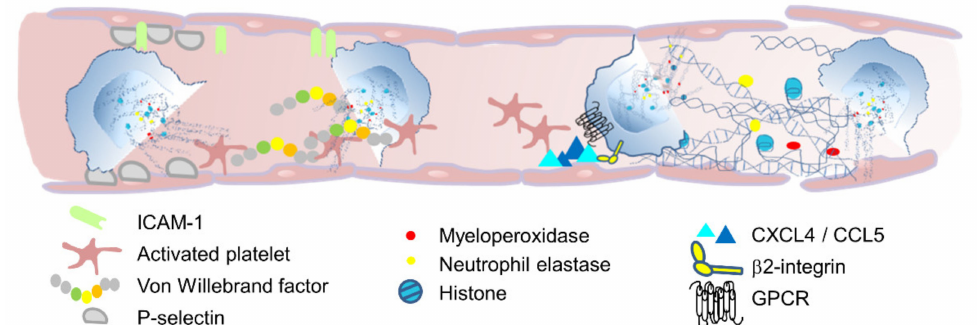
Figure 2. Schematic illustration of how NETs might contribute to vaso-occlusion and endothelial damage. NETs are able to promote vaso-occlusion, initiated by von Willebrand production in platelets, which induces the upregulation of intercellular adhesion molecule-1 (ICAM-1), further strengthening neutrophil–endothelium interactions. Platelet-dependent NET formation requires the heterodimerized CXCL4 and CCL5, as well as the simultaneous stimulation of GPCRs and integrins. NET-derived NE cleaves the coagulation-inhibiting tissue factor pathway inhibitor (TFPI) and, in parallel, activates platelet receptors to increase platelet accumulation. NET-decorated proteins further contribute to tissue damage. Histones especially exhibit cytotoxic effects, disturbing the endothelial